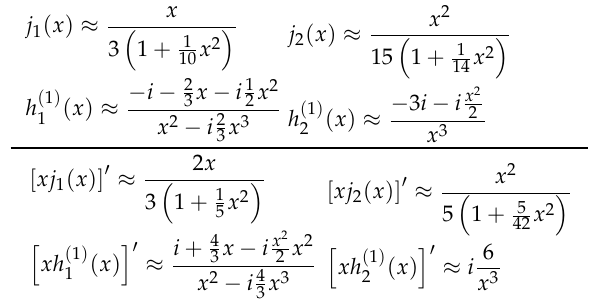
Table A1. Padé approximants of j n ( x ) and h j 1 ( x )